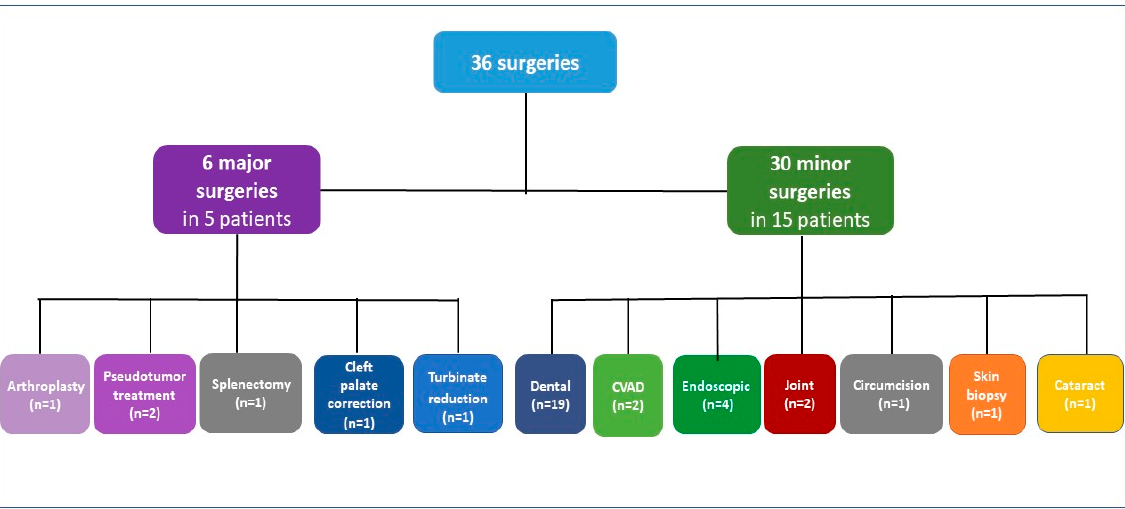
Figure 2. Types of surgeries in patients with severe hemophilia A without inhibitors. n refers to the number of surgeries. Patients with both minor and major surgeries are counted in both categories; CVAD, central venous access device.